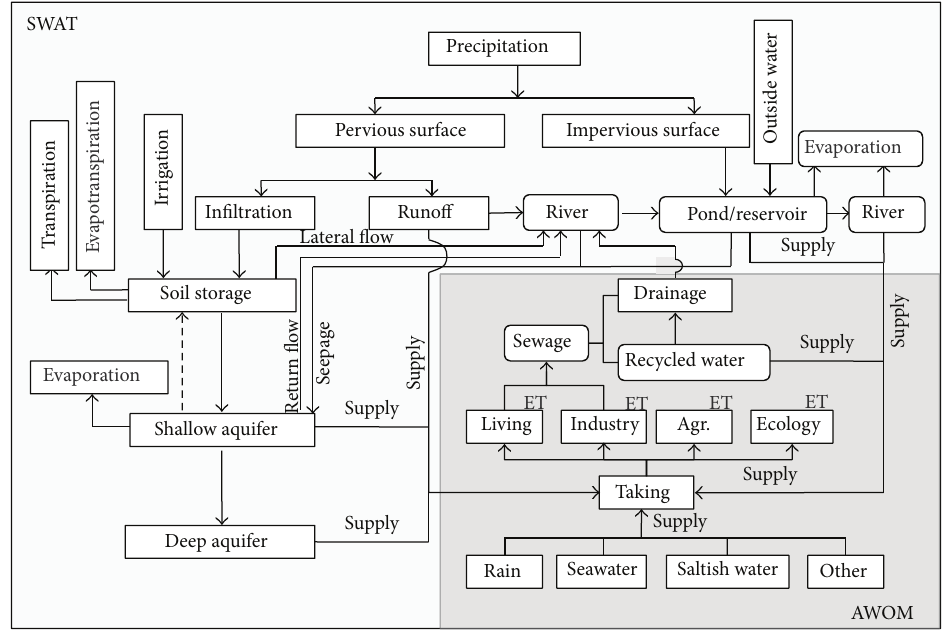
Figure 2: The flow chart of the WAS model.